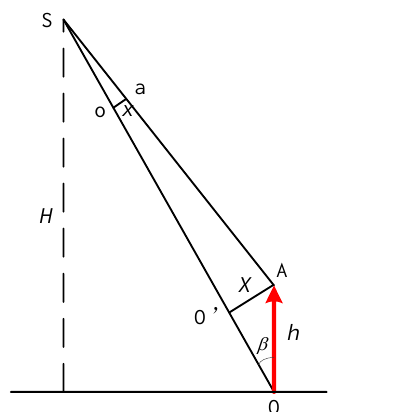
Figure 3. The side view of the satellite imaging scene